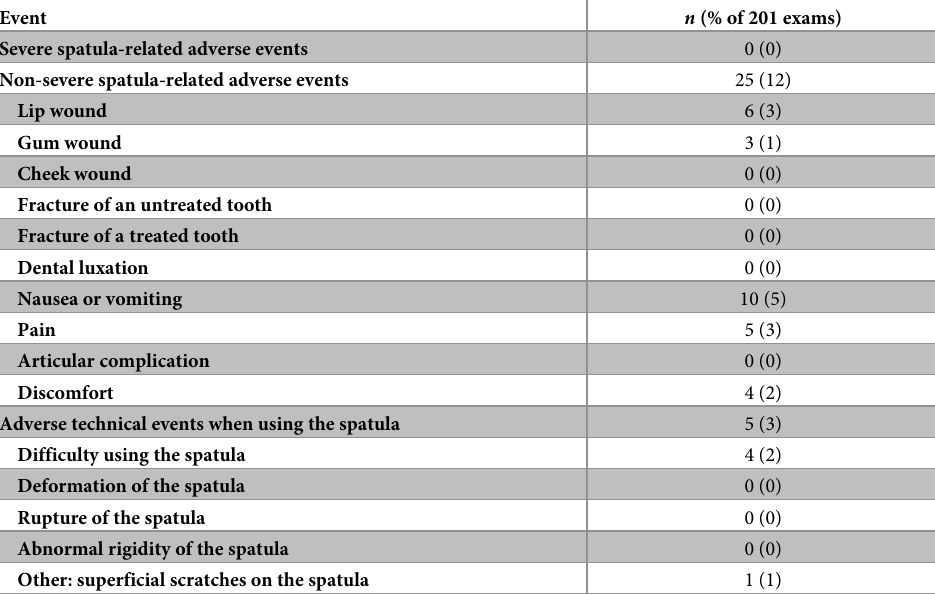
Table 3. Medical and technical adverse events related to the use of the spatula ( n =